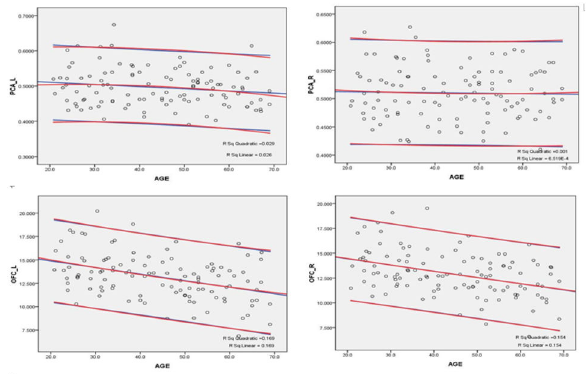
compared to the younger groups. Correlations between PCA and OFC volume and olfactory function Pearson’s partial correlation analyses controlling for ICV revealed a significant correlation between OFC and DIS on the correlation on the left side (r = 0.165, p = 0.085). The 108